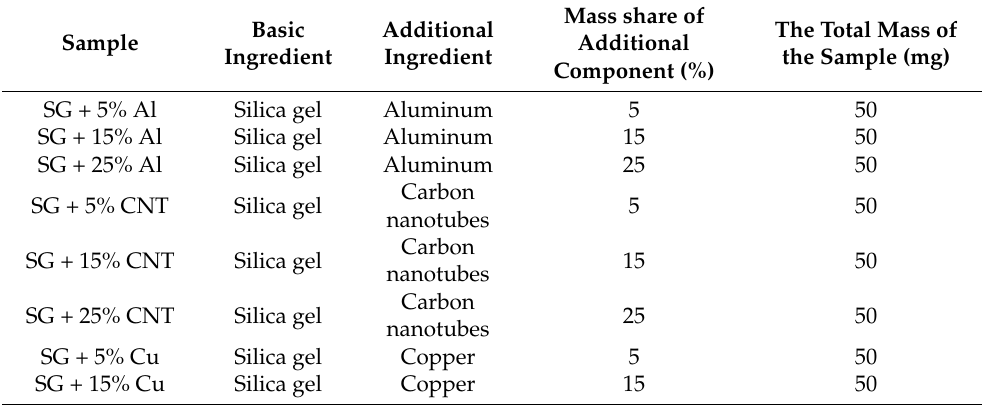
Table 1. Use of additives Aluminum (Al), Carbon nanotubes (CNT), Copper (Cu) for Silica gel